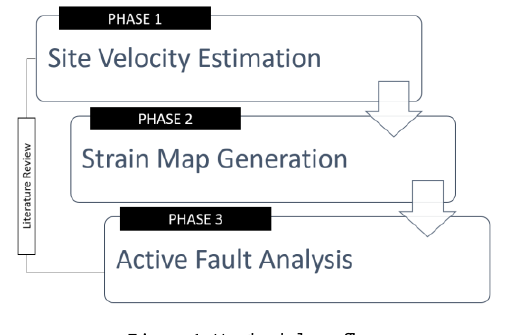
Figure 1. Methodology flow